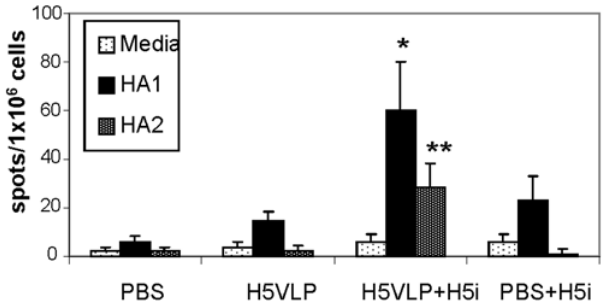
Figure 9. IFN- c ELISPOT. Naı¨ve, unimmunized mouse control, H5VLP, H5VLP + H5i and N (naı¨ve) + H5i, groups of mice (n=6 for each group) intranasally immunized as described in the legend of Fig. 8. Spleen cells were collected from individual mouse and stimulated with H5 HA1 or H5 HA2 peptide pool derived from A/Thailand/16/04 (H5N1). * and ** indicate significant differences between H5VLP + H5i and H5VLP or PBS + H5i group (p , 0.05 and p , 0.005, respectively) as determined by Student’s 2-tailed